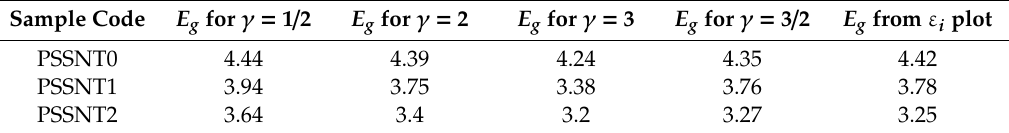
Table 5. Band gap E g from Tauc’s method ( α h υ ) 1 / γ versus photon energy h υ and the optical dielectric loss ε ” plot, where α represents the absorption coe ffi cient.